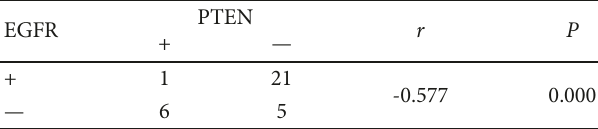
Table 2: Correlation between EGFR and PTEN expression (cases).